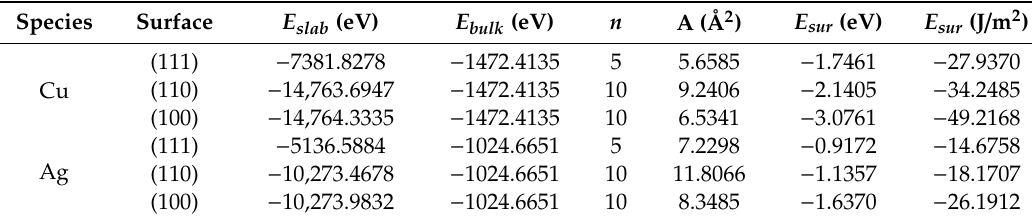
Table 1. Surface energy after geometric optimization.